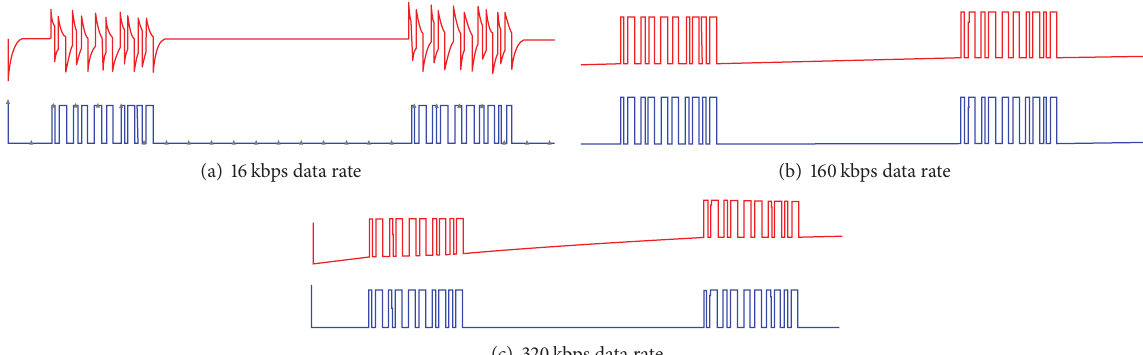
Figure 11: (a), (b), and (c) show the comparison results of AC coupling (red color) and improved DC coupling amplifier (blue color) in 16kbps, 160kbps, and 320 kbps data rate.